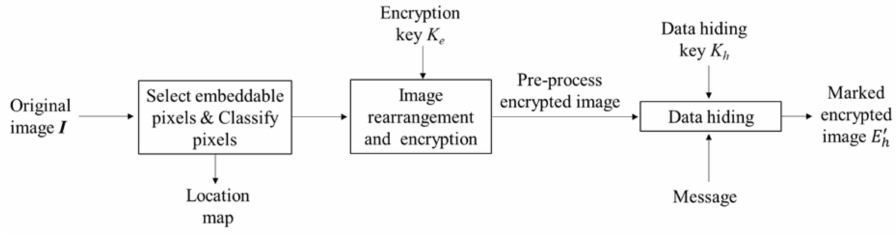
Figure 4. Overview of the encoding